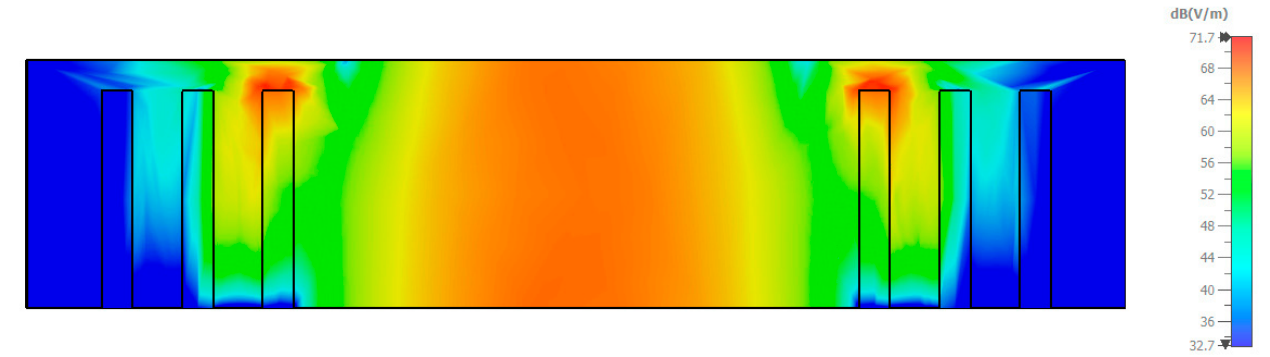
Figure 4. Groove gap waveguide cross-section electric field @ 9.5 GHz.